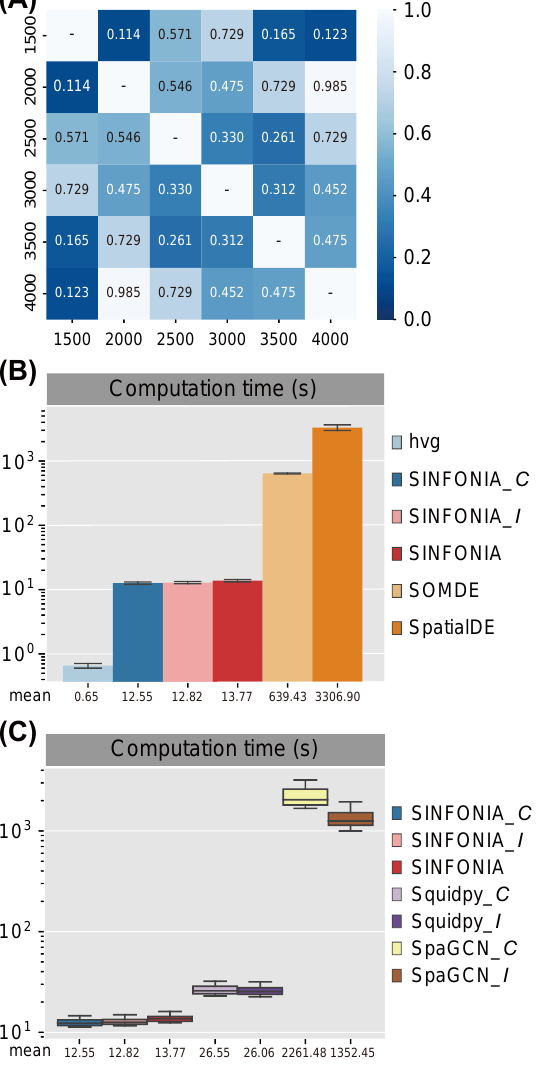
Figure 6. ( A ) p -values of two-sided Wilcoxon signed-rank tests on the performance of different numbers of SVGs identified by SINFONIA. ( B ) Computation time of different methods on 12 DLPFC datasets. ( C ) Computation time of different implementations for calculating spatial autocorrelation statistics on 12 DLPFC datasets.